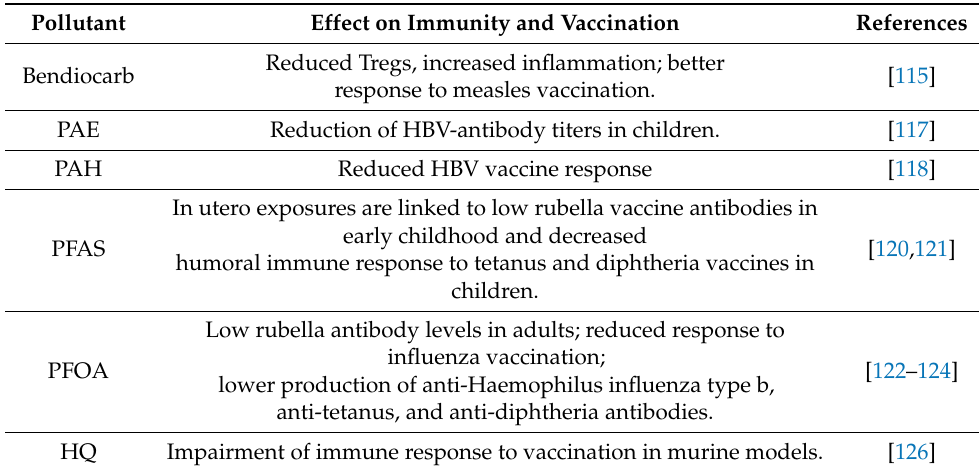
Table 3. Pollutants and